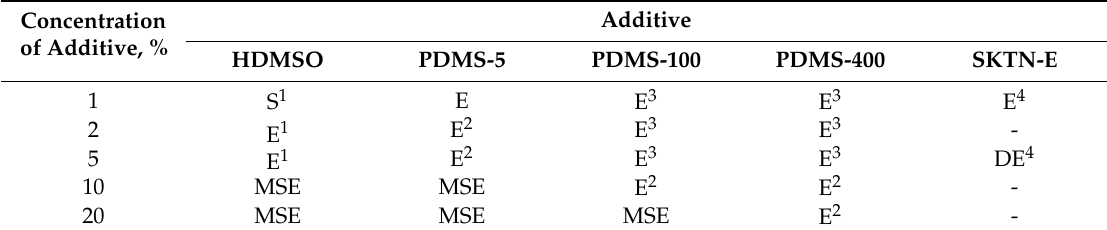
Table 2. Compositions under consideration: S—solution; E—emulsion; DE—double emulsion; MSE—macro-phase